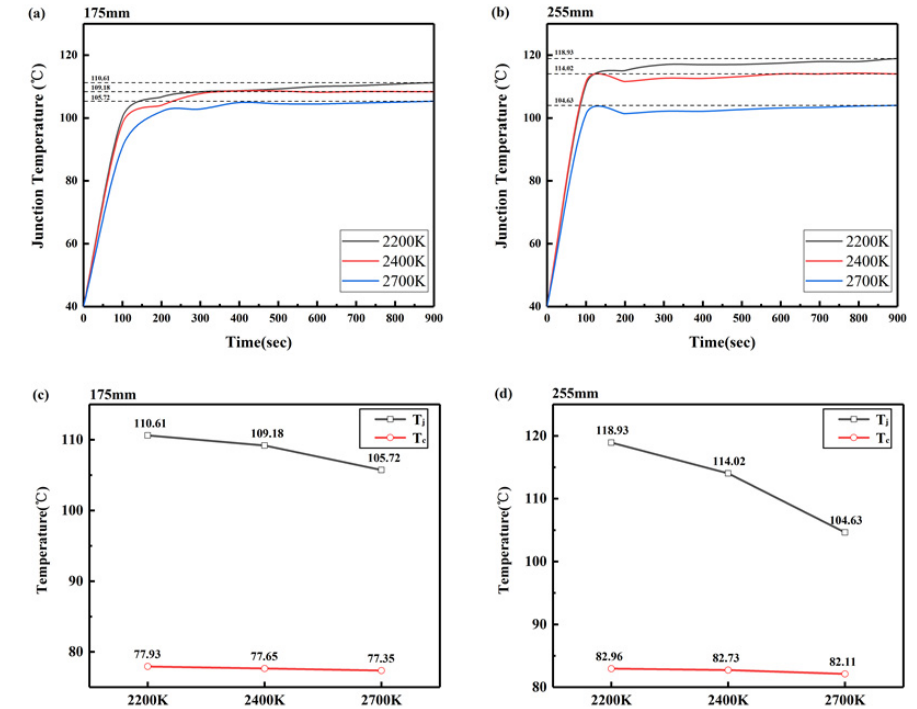
Figure 4. ( a ) Junction temperature curve (175 mm); ( b ) Junction temperature curve (255 mm); ( c